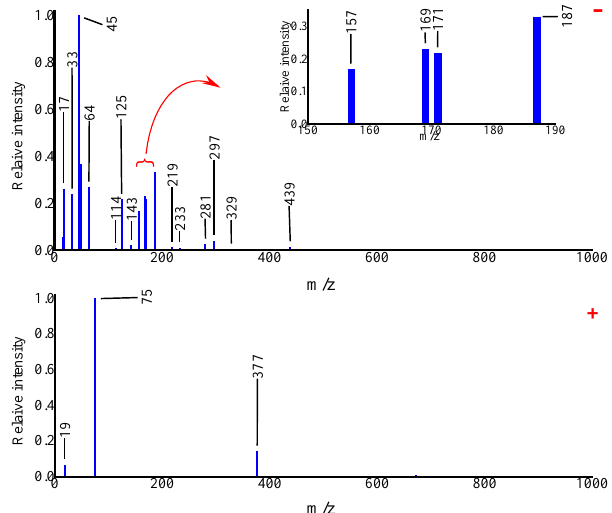
Figure 5. Averaged ATOFMS negative and positive ion mass spec- tra for small processed OL particles ( D p